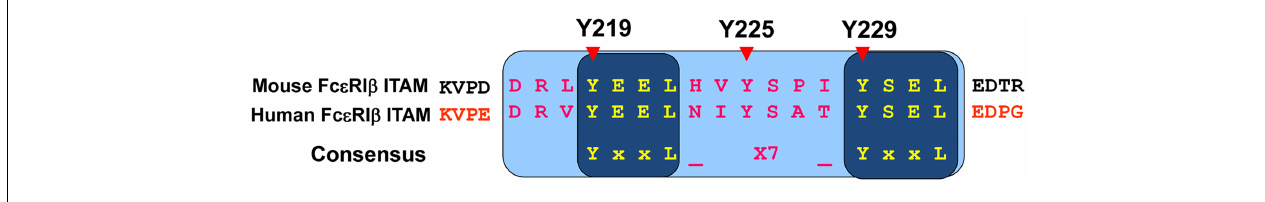
FIGURE 4 | Fc ε RI β chain ITAM sequence .The Fc ε RI β chain contains a non-canonical tyrosine residue at position 225, which is involved in the negative regulation for mast cell activation.